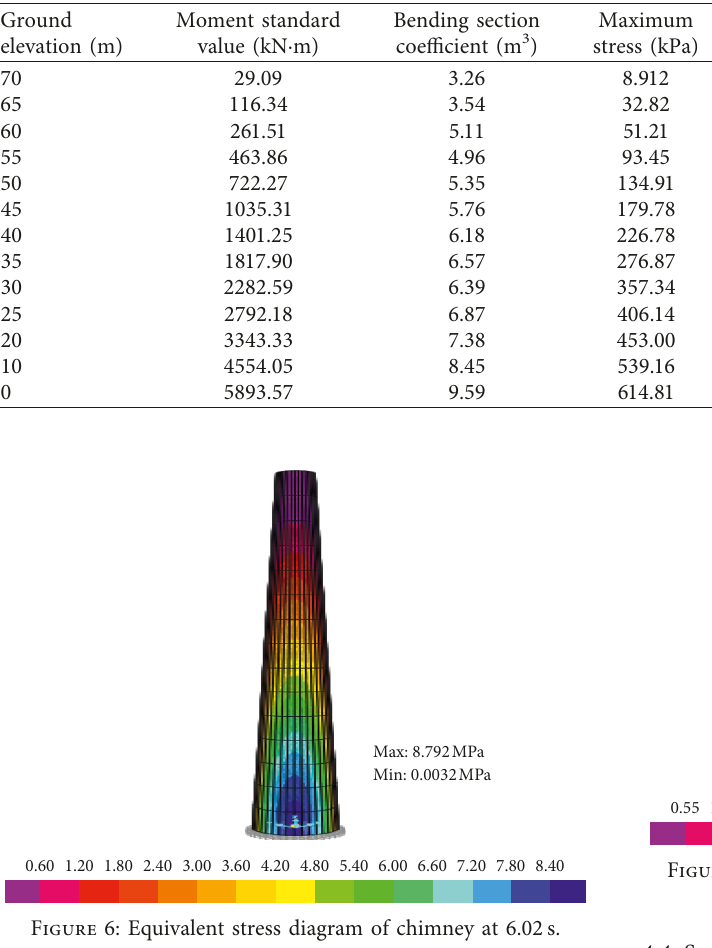
Table 7: Moment stress under the action of wind.